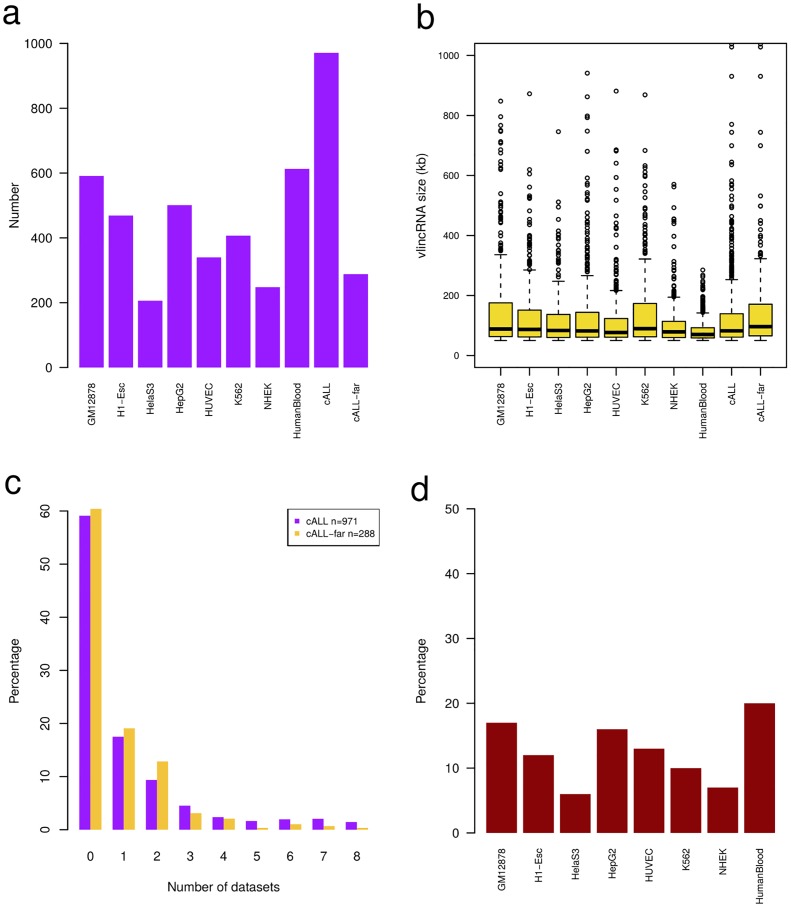
Characterization of cALL-derived vlincRNAs.(A) Number of vlincRNAs previously reported for diverse cell types (GM12878, H1-Esc, HelaS3, HepG2, HUVEC, K562, NHEK, HumanBlood) [9] and discovered in our cALL dataset, including ‘far-from-genes’ cALL vlincRNAs that are at least 10 kb away from protein-coding genes. (B) Boxplot of vlincRNA transcript sizes. (C) Percentage of all (n = 971) and ‘far-from-genes’ (n = 288) cALL vlincRNAs overlapping vlincRNAs a given number of public datasets. (D) Percentage of cALL vlincRNAs overlapping vlincRNAs from public datasets (HumanBlood data is unstranded).